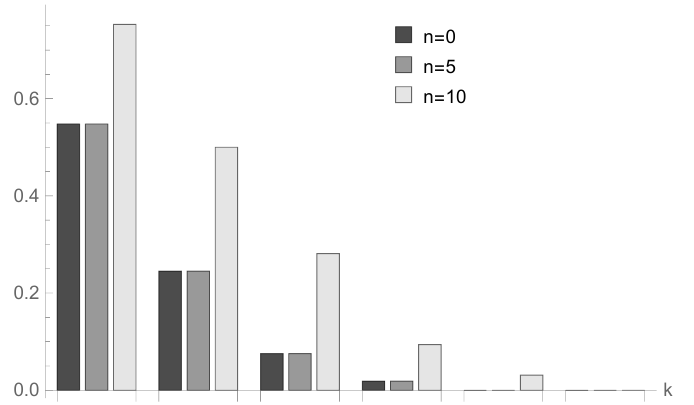
Figure 5. Conditional probabilities (cid:98) ∆ n ( k ) for deterministic processing distribution, (cid:36) = 1.00 and n = 0,5 and 10.